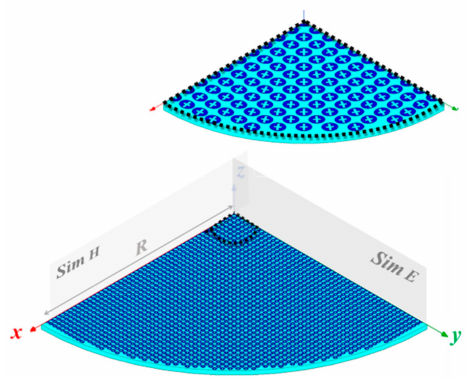
Figure 6. Details of the rotationally symmetric metasurface composed by pixel B subwavelength elements. Total radius R = 50 u = 157 mm. The structure is excited by a magnetic dipole oriented towards the y -axis. The metal patches are shown in dark blue, whereas the light blue color represents the dielectric substrate.